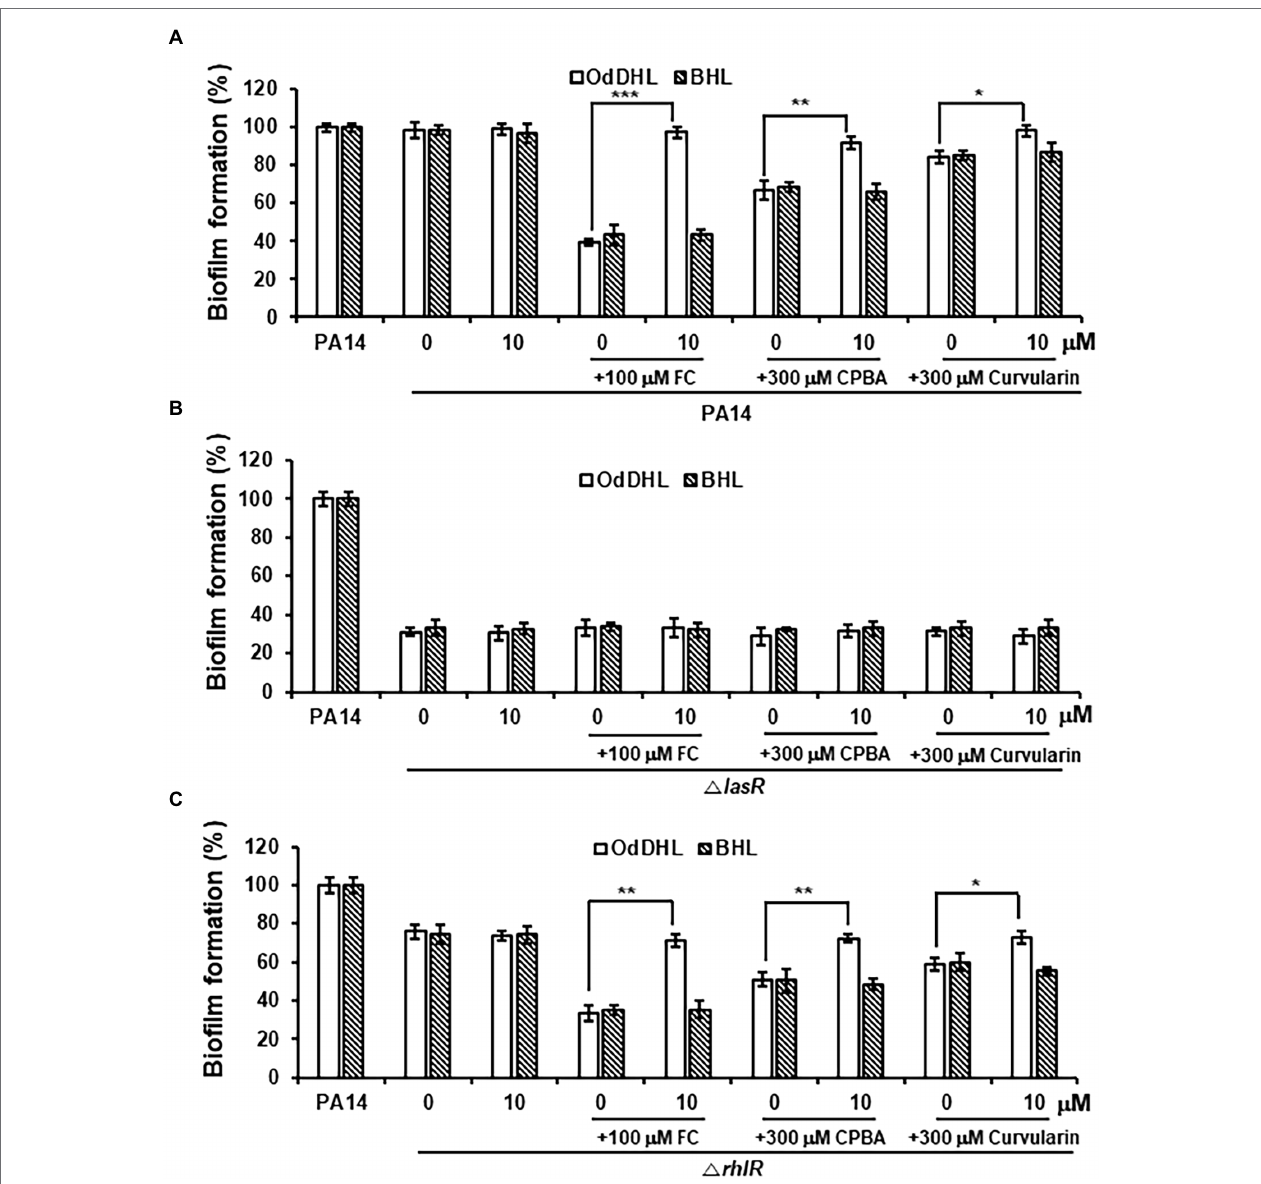
FIGURE 8 | Effects of exogenous QS ligands on curvularin-mediated inhibition of biofilm formation in Δ lasR and Δ rhlR mutants. Biofilm formation in wild-type PA14 (A) , the Δ lasR mutant (B) , and the Δ rhlR mutant (C) cultured with curvularin (300 μ M) in the presence or absence of different concentrations of OdDHL or BHL for 18 h. FC and CPBA are known antagonists of LasR and RhlR, respectively. The data are representative of three independent experiments performed in triplicate and expressed as the mean ± SD values in each bar. * p < 0.01; ** p < 0.001; and *** p < 0.0001 versus DMSO